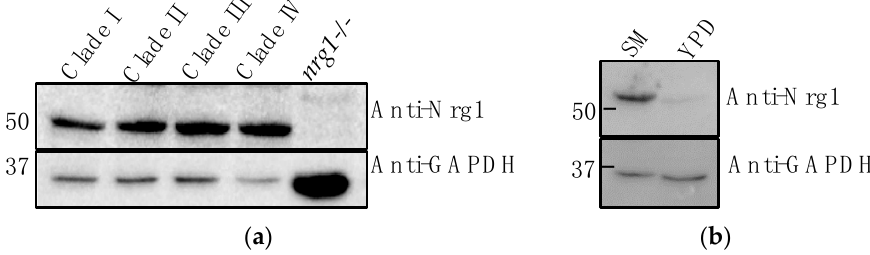
Figure 6. Nrg1p expression among different clades of C. auris and in different growth conditions. ( a ) Western blot of cytosolic proteins of 4 different clades of C. auris . Clade 1 (South Asia, Saudi Arabia, lab strain #1126), Clade II (AR bank #0381, East Asia), Clade III (AR bank #0383, Africa), Clade IV (AR bank #0386, South America). C. albicans nrg1 − / − null mutant was included as a negative control. Anti-GAPDH (human, HRP-conjugate) was used as a loading control. ( b ) Cytosolic proteins from C. auris grown in synthetic sweat medium (SM) and YPD broth medium were probed against anti- Cal Nrg1 antibody (upper panel). Equal amounts of protein loading were confirmed by use of anti-GAPDH-HRP conjugate (human)